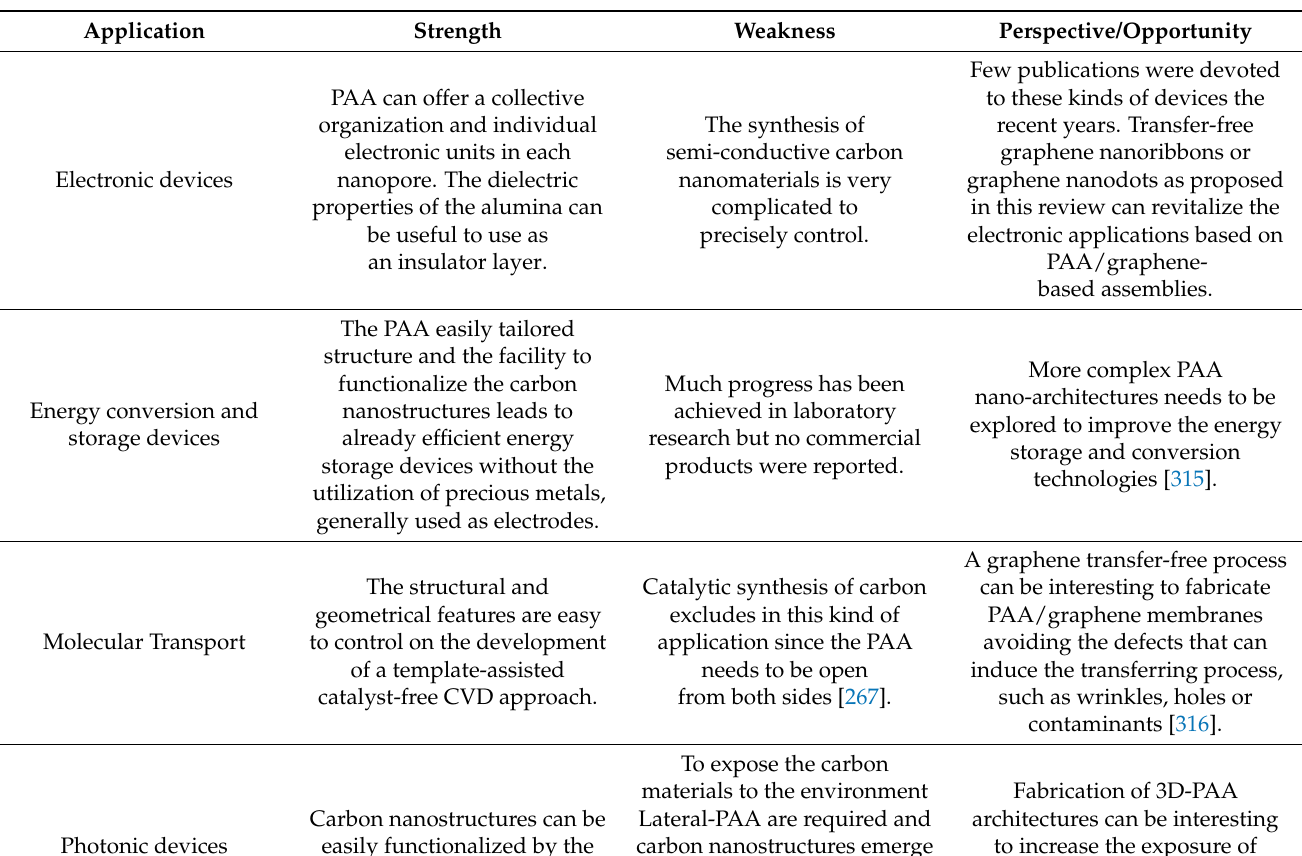
Table 1. Strength and weakness of the used PAA/carbon nanostructure in the above-mentioned